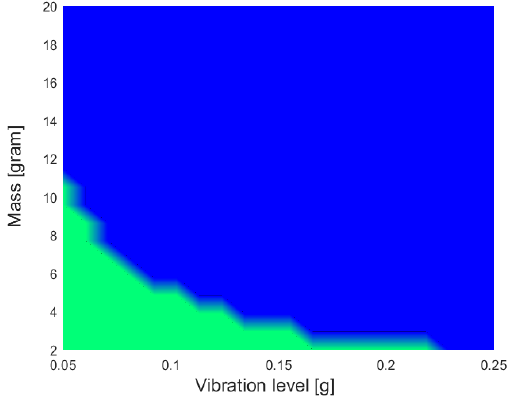
Figure 13. Simulation results: range of parameters where the piezoelectric harvester provides higher powers (green area) vs. that where the electromagnetic harvester performs better (blue area) [58].